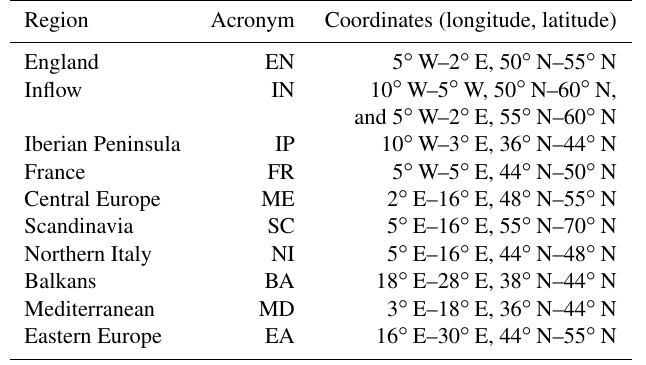
Table 3. List of regions with the acronym and coordinates.